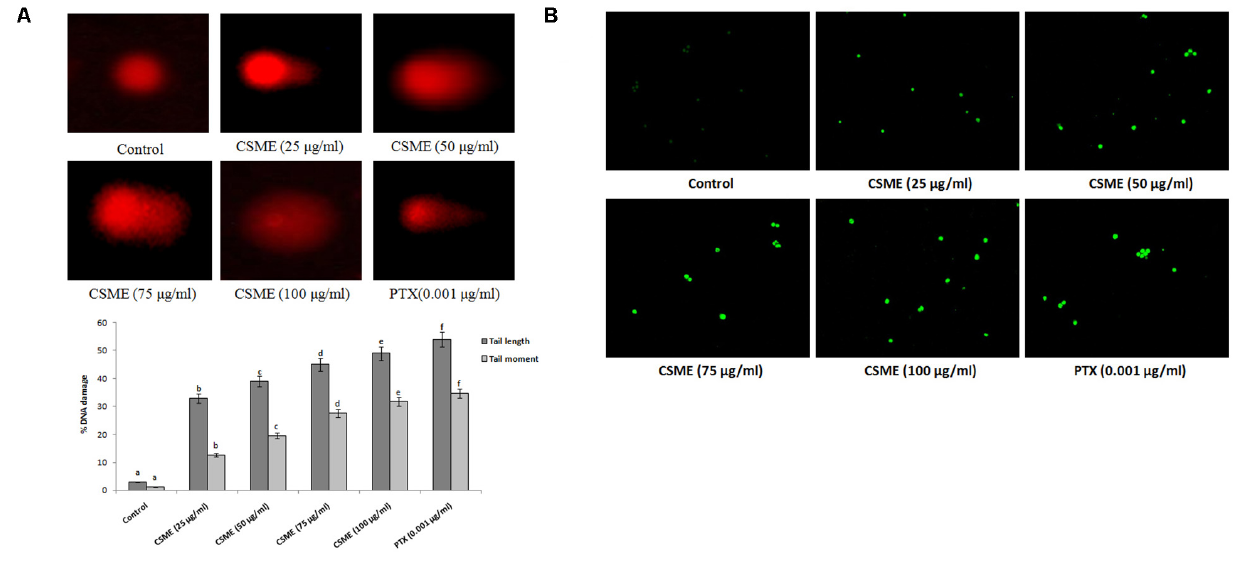
Frontiers in Cell and Developmental Biology |